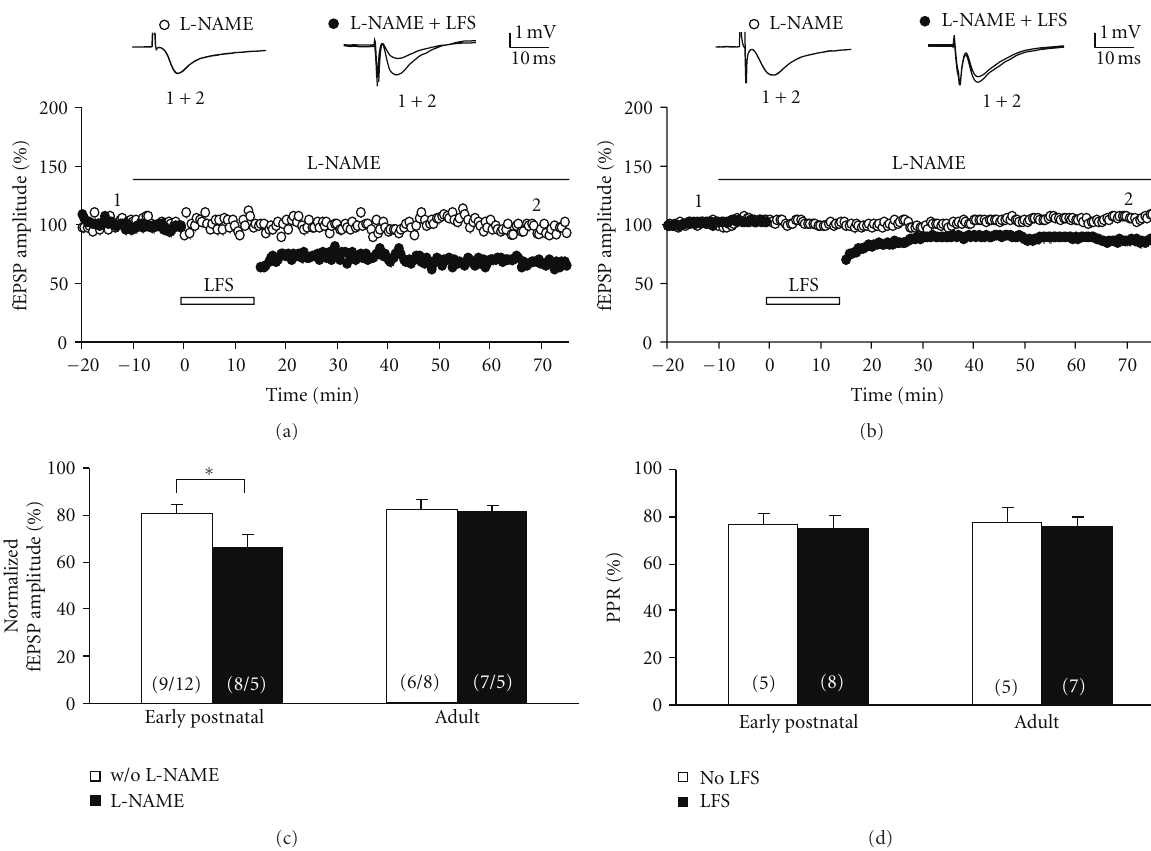
Figure 4: L-NAME enhances LFS-induced LTD in early postnatal, but not adult, rats. (a) The time course of the fEPSP amplitude following LFS in early postnatal rats (P9–15) shows robust LTD (closed symbols) as compared to time-control experiments without LFS (open symbols). L-NAME (100 µ M) was applied 10 min prior to LFS (indicated by a lack bar). Representative fEPSPs were taken at the beginning (indicated by “1”) and at the end (indicated by “2”) of the experiment. (b) The time course of the fEPSP amplitude following LFS in adult rats (P30–60) also shows LTD (closed symbols) as compared to time-control experiments without LFS (open symbols). L-NAME (100 µ M) was applied 10min prior to LFS (indicated by a lack bar). Note that less LTD is obtained compared to early postnatal animals (panel A). Representative fEPSPs were taken at the beginning (indicated by “1”) and at the end (indicated by “2”) of the experiment. (c) The bar graph summarizes the LTD levels for slices treated with L-NAME (closed bars). For the sake of clarity, data from Figures 1(e) and 2(d) is also shown in order to illustrate non-L-NAME conditions (open bars). The number of slices is given in parentheses (number of LFS-treated slices/number of non-LFS-treated slices). (d) The bar graph summarizes the paired-pulse ratio of all experimental groups recorded at the beginning of each experiment, that is, before L-NAME and/or LFS were applied to the slices. Note that the PPR was similar in all groups. All data are mean ±